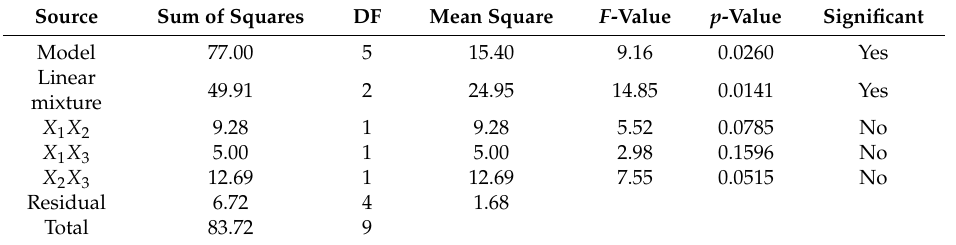
Table 12. ANOVA results for retardation time ( τ ).